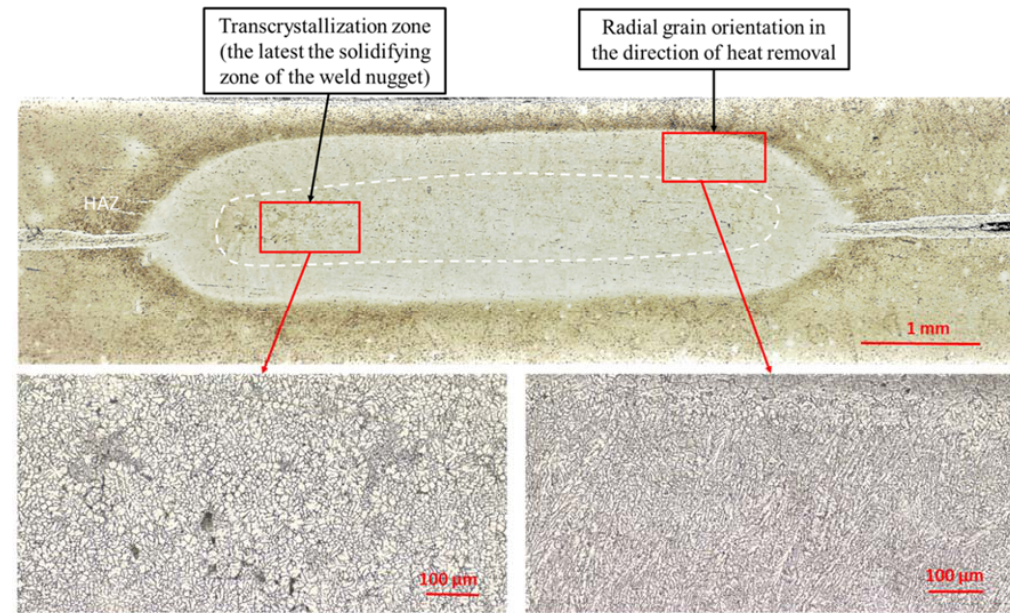
Figure 6. Weld nugget zones in RSW joint.